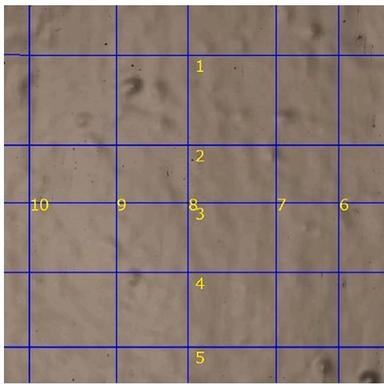
Example of lines distribution for surface roughness measurements.